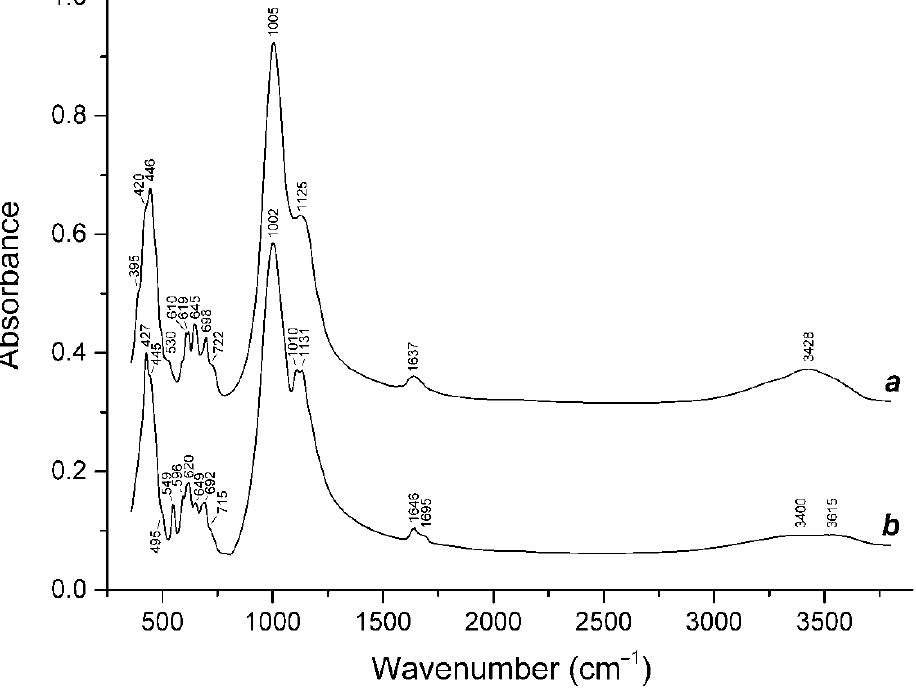
Figure 18. Infrared spectra of ( a ) franzinite, Sample 14, and ( b ) marinellite, Sample 15.